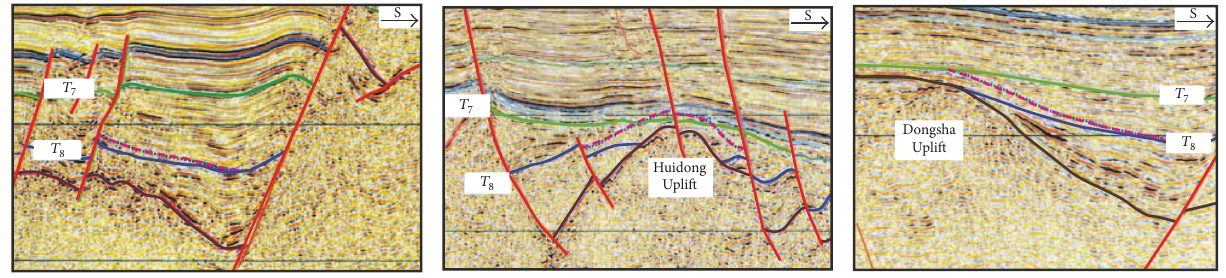
Figure 14: Method to estimate the erosion thickness in the Huizhou Sag [59] (the sequence boundaries are shown in Figure 2).